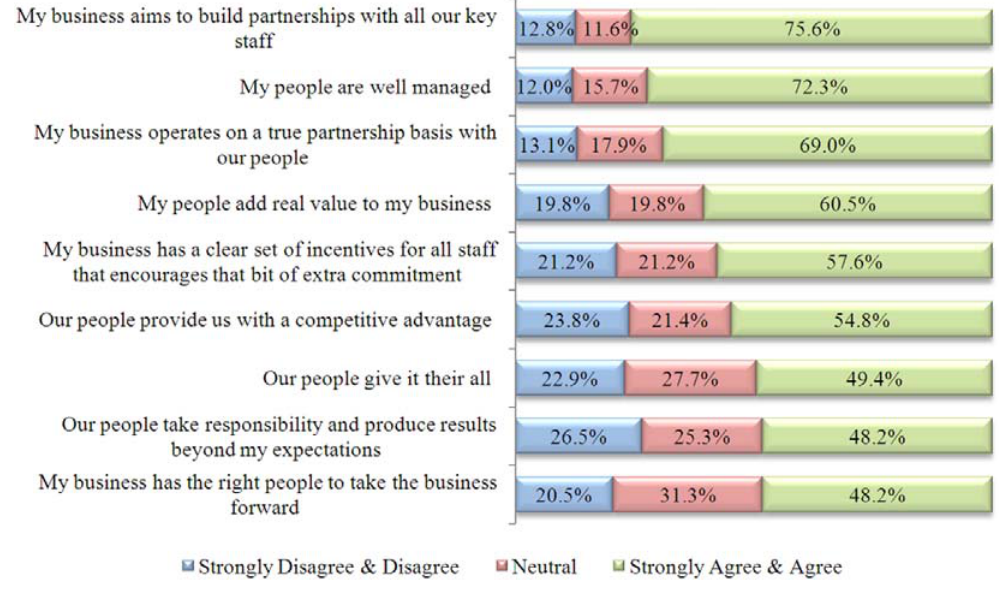
Fig. 3. Levels of agreement with how HR is being